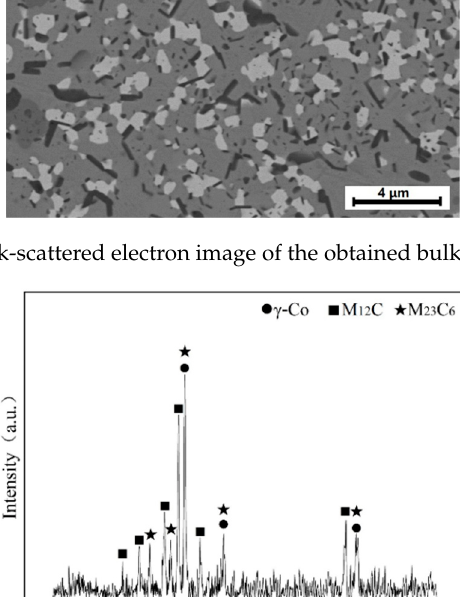
Figure 4. XRD result of the obtained bulk cobalt-based alloy.